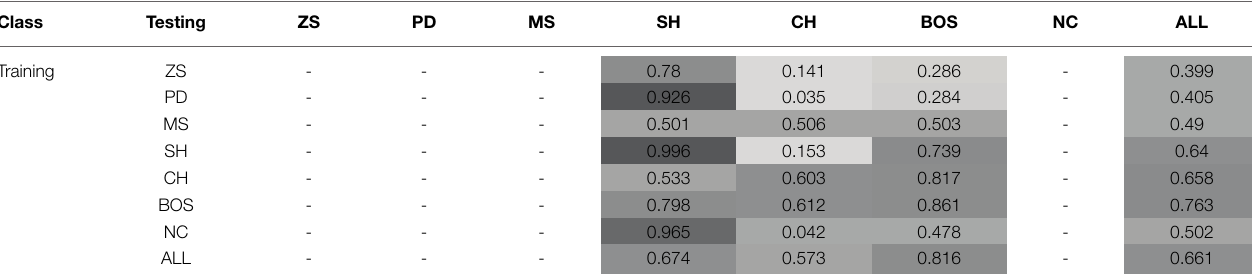
TABLE 6 | Joint probability of playing a PSNE (conditional on the training and test sets)—Games with two PSNE.